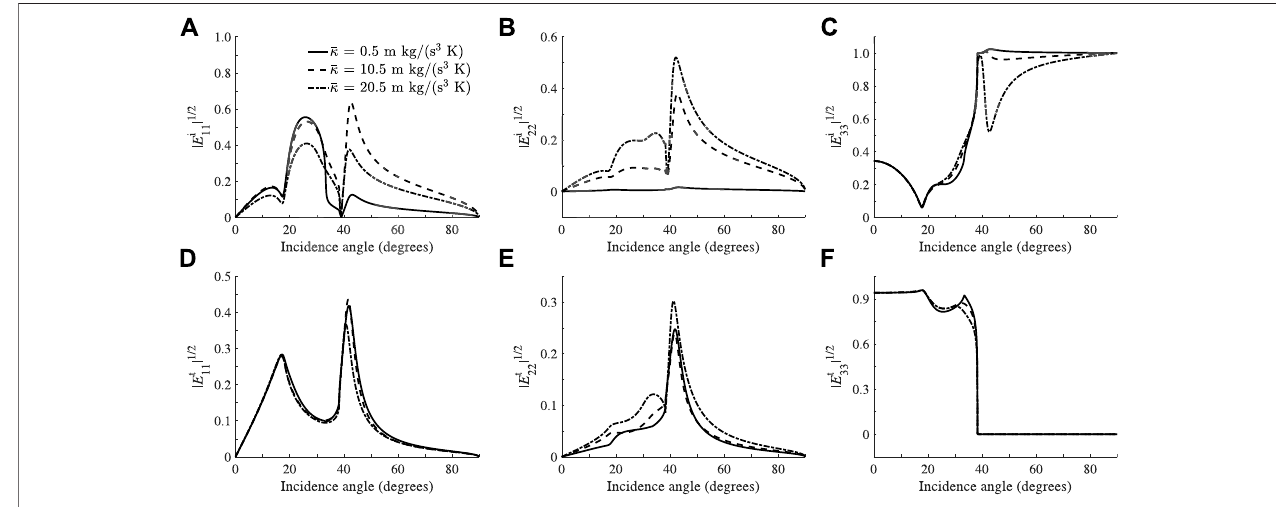
FIGURE 15 | Same as Figure 14 but for the square root of the energy ratios of the re fl ected P (A) , re fl ected T (B) , re fl ected S (C) , transmitted P (D) , transmitted T (E) and transmitted S (F) waves, considering the fl ux in the z -direction.